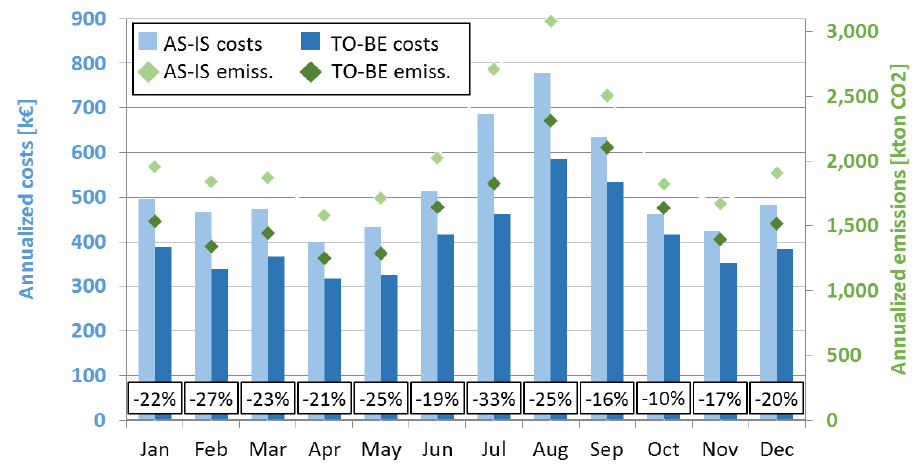
Figure 14. Monthly economic and emission saving in the TO-BE scenario 1 compared to the AS-IS scenario.